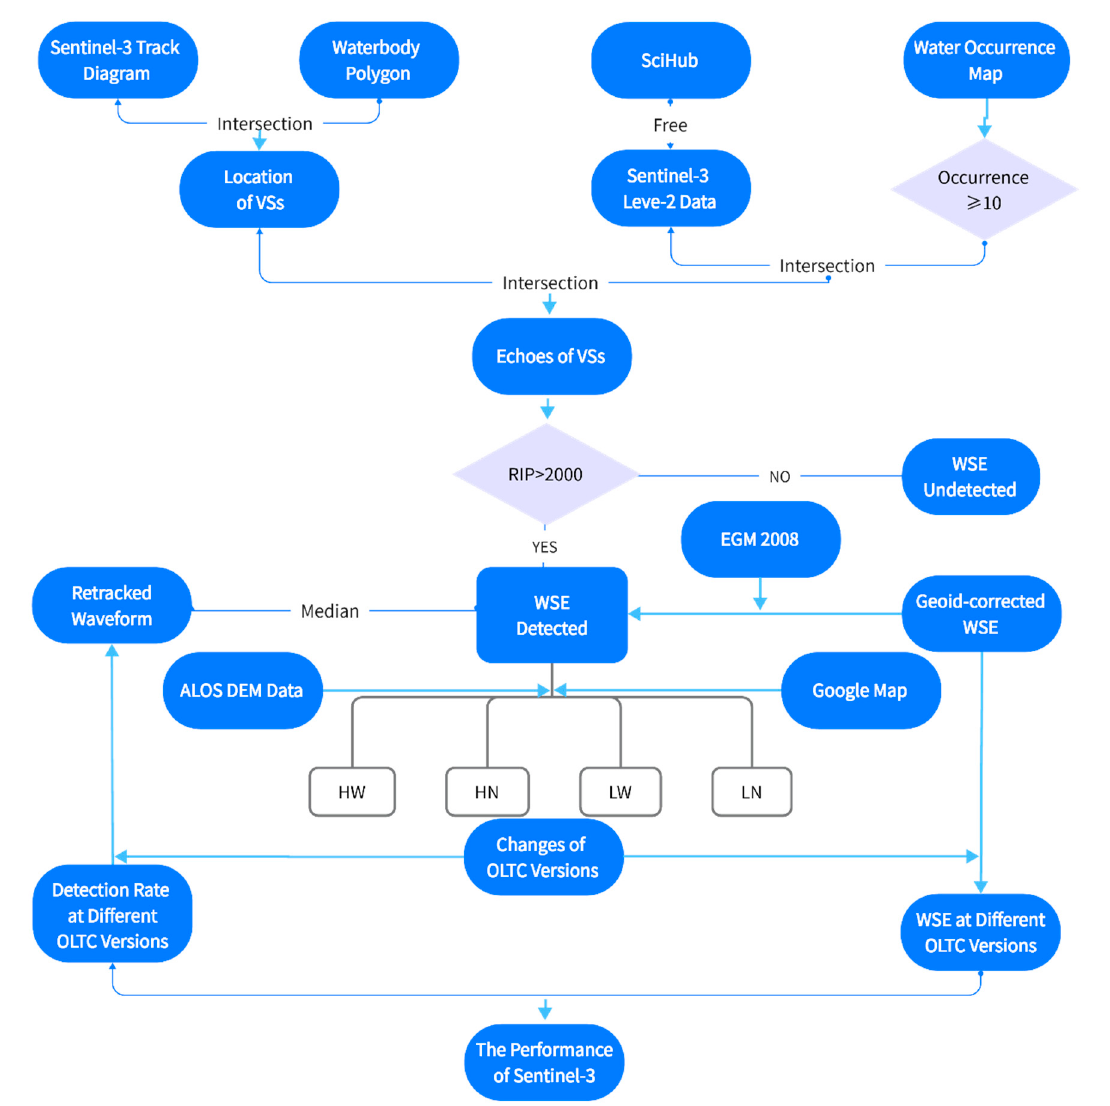
Figure 3. Research methodology flowchart.